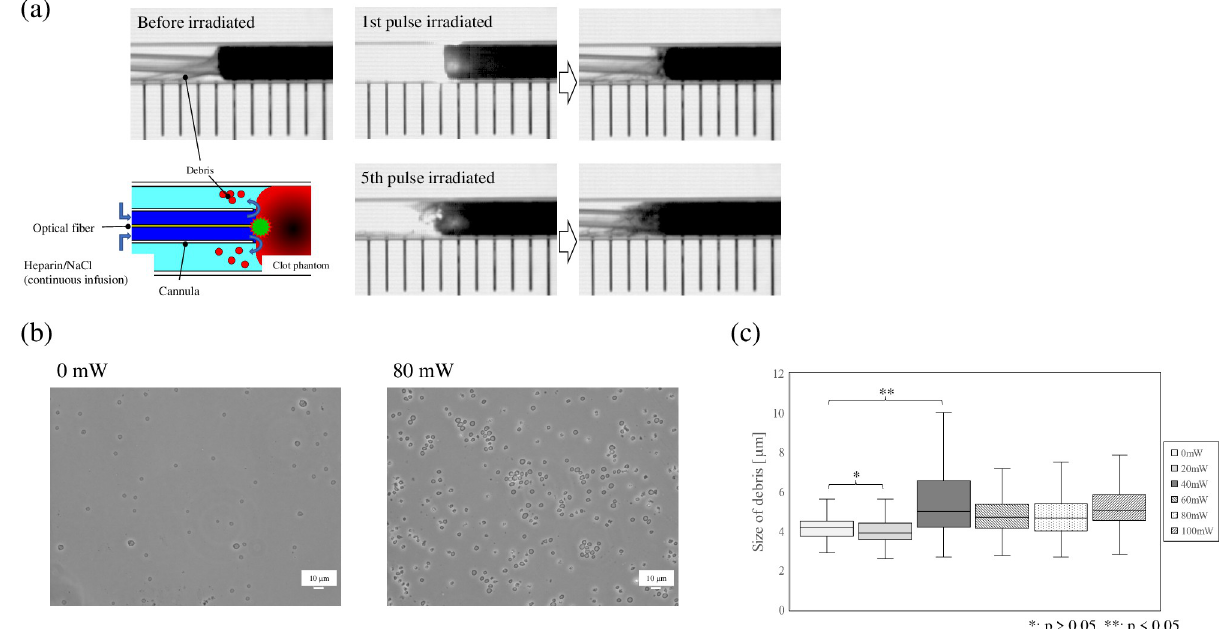
Fig 6. Typical response of the clot phantom to pulsed laser irradiation. (a) Block diagram and real images of the in vitro clot phantom experiment. Significant generation of debris was observed after pulsed irradiation. Incidence energy: 16 mJ/pulse, pulse width: 100 μ s, frequency: 5Hz, frame rate: 60fps, exposure time: 250 μ s. A glass tube (inner diameter: 2 mm) was filled with a blood clot phantom and saline solution, and pulsed laser irradiation was performed continuously for 10 seconds (total: 50 shots). The optical fiber was inserted in a polyethylene tube (inner diameter: 0.40 mm, outer diameter: 0.80mm), which resembled a catheter, to prevent scorching of the blood clots, and heparinized saline (concentration: 20 U/mL, flow rate: 6 mL/h) was continuously administered during the irradiation to prevent scorching of the blood clots. Upper group of photos: before irradiation and after irradiation by one pulse. Lower group of photos: after irradiation by five pulses. The boundary between the blood clot phantom and the saline solution became unclear as the number of irradiations increased. (b) Debris collected after 10 s of irradiation and observed under a phase-contrast microscope (without staining). The average power was 0 mW (left) and 80 mW (right). (c) Size of debris ( � ; p > 0.05, �� ; p < 0.05, Vertical axis: size of debris observed after irradiation). https://doi.org/10.1371/journal.pone.0262991.g006 PLOS ONE | https://doi.org/10.1371/journal.pone.0262991 January 27,